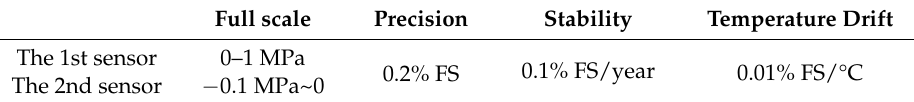
Table 5. The static parameter characteristics of the two pressure transmitters.